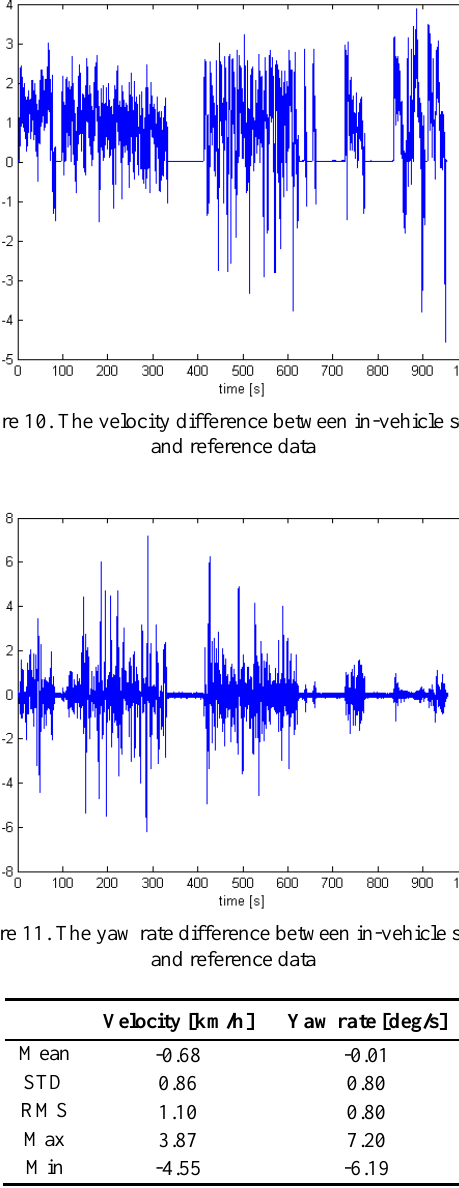
Table 12. The discrepancy between built-in sensor data and reference